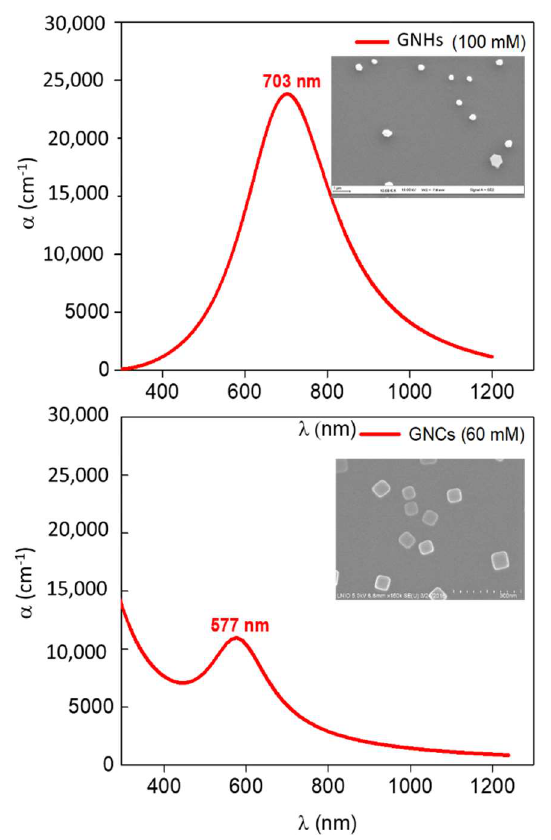
Figure 7. Absorption coefficient spectra for gold nanocubes prepared with 60 mM of NaAuCl 4 precursor and for GNH prepared using 100 mM of HAuCl 4 precursor. The inserts correspond to Figure 4a,b, Figure 4b and Figure 4a, respectively.